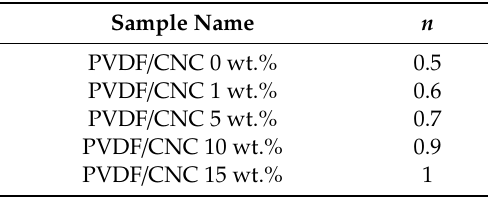
Table 4. n exponent for all PVDF/CNC nanocomposites.